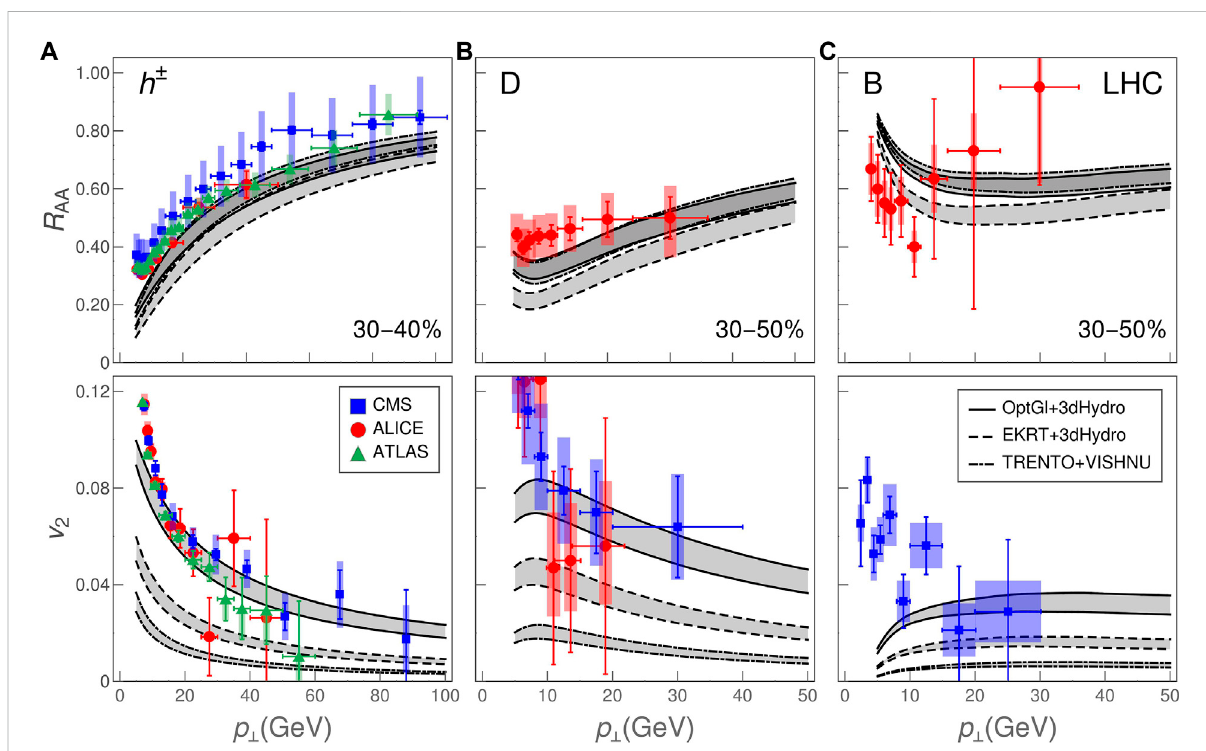
FIGURE 6 DREENA-A R AA (top panels) and v 2 (bottom panels) predictions in Pb + Pb collisions at QGP medium evolution (indicated in the legend). Charged hadron (A) predictions are generated for 30 – 40% centrality, while D (B) and B (C) meson predictions are generated for 30 – 50% centrality region. For charged hadrons, the predictions are compared with the experimental data from CMS [88, 89], ALICE [90, 91] and ATLAS [92, 93]. For D mesons, the predictions are compared with ALICE [94, 95] and CMS [96] data. For B mesons predictions are compared with preliminary ALICE [97] and CMS [98]. The boundary of each gray band corresponds to 0.4 < μ M / μ E < 0.6 [67,